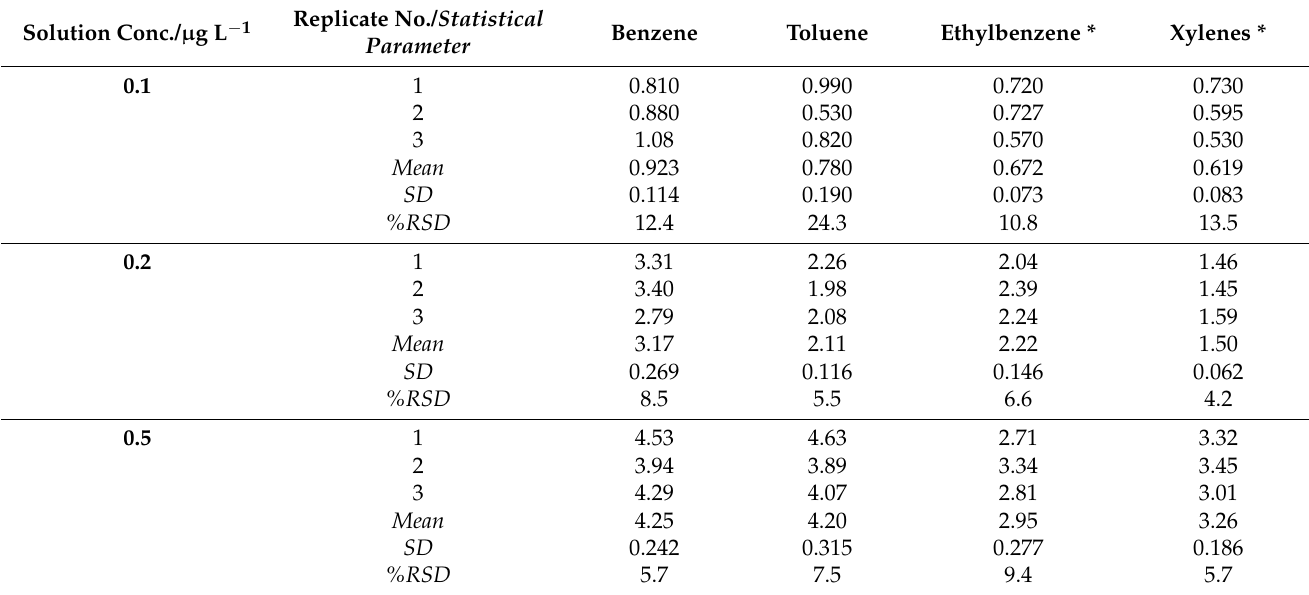
Table 4. Determination of the method LOQ for BTEX using solution concentrations of 0.1, 0.2, and 0.5 µ g L − 1 . Headspace concentrations, means and standard deviations (SD) are reported in ppbV and the RSD is reported as a percentage.